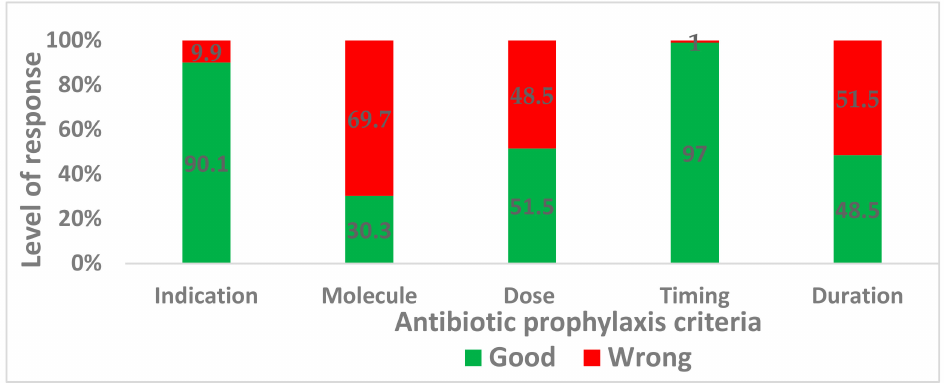
Figure 1. Level of response of the healthcare